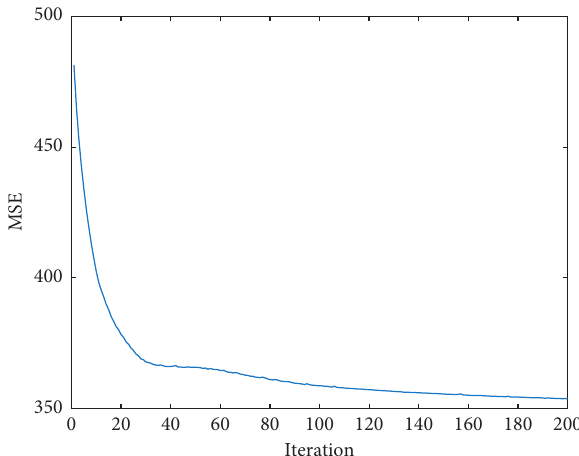
Figure 8: MSE evolution of the neurocontroller with a sinusoidal wind speed.